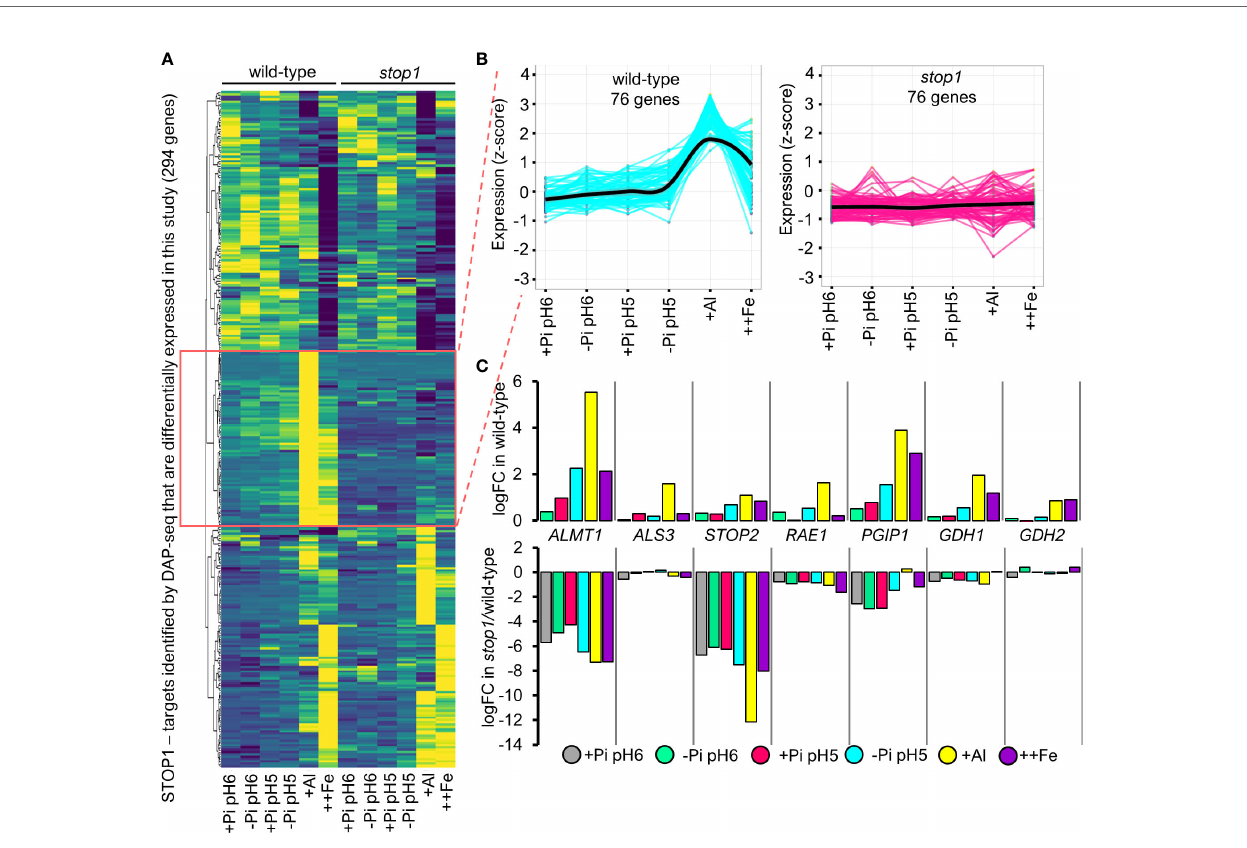
FIGURE 5 | STOP1 triggers the expression of a speci fi c set of its targets that correlate with its accumulation and are important for root tolerance in response to abiotic stress factors prevalent in acidic soils. (A) Heatmap of normalized gene expression (z-score) of 294 STOP1-target genes that are differentially expressed under any of the tested treatments (FDR <.05) identi fi ed by DNA Puri fi cation Af fi nity (O ’ Malley et al., 2016). Pearson clusterization was used to cluster genes with similar expression pro fi les, 5 gene subsets were obtained and the subset of 76 genes that correlate with STOP1 accumulation is highlighted. Gene identi fi ers and description of the 5 resulting subsets of STOP1-targets is included in Supplementary Table 1 . (B) Normalized gene expression pro fi les (z-score; y-axis) of the subset of 76 STOP1-targets highlighted in (A) of wild-type and stop1 seedlings in response to the tested treatments (x-axis). (C) Changes in the expression in log2 of fold change (logFC) of STOP1-targets in response to the indicated treatments with respect to the expression in control conditions (+Pi_pH6 treatment in wild- type). A table with the logFC of the 294 STOP1-targets is included in Supplementary Table 1